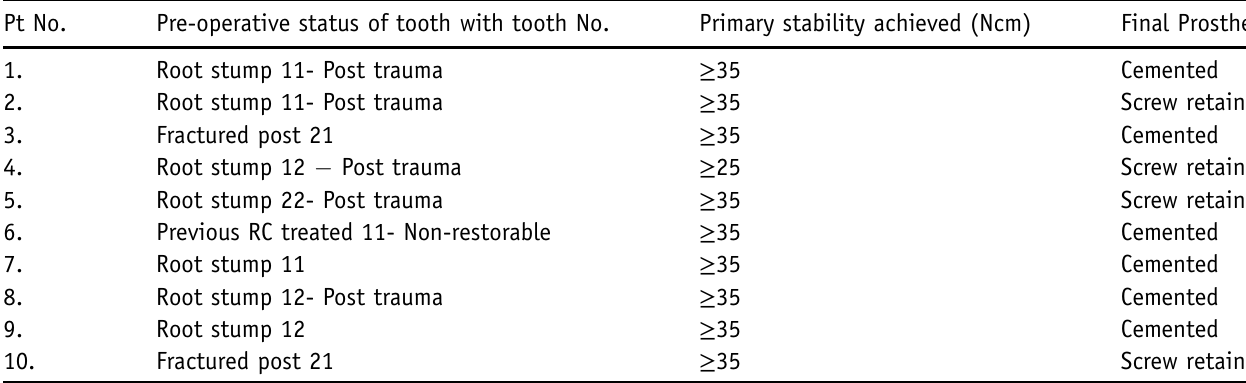
Table IV. Showing indication for replacement, primary stability achieved and type of fi nal prosthesis. Pt